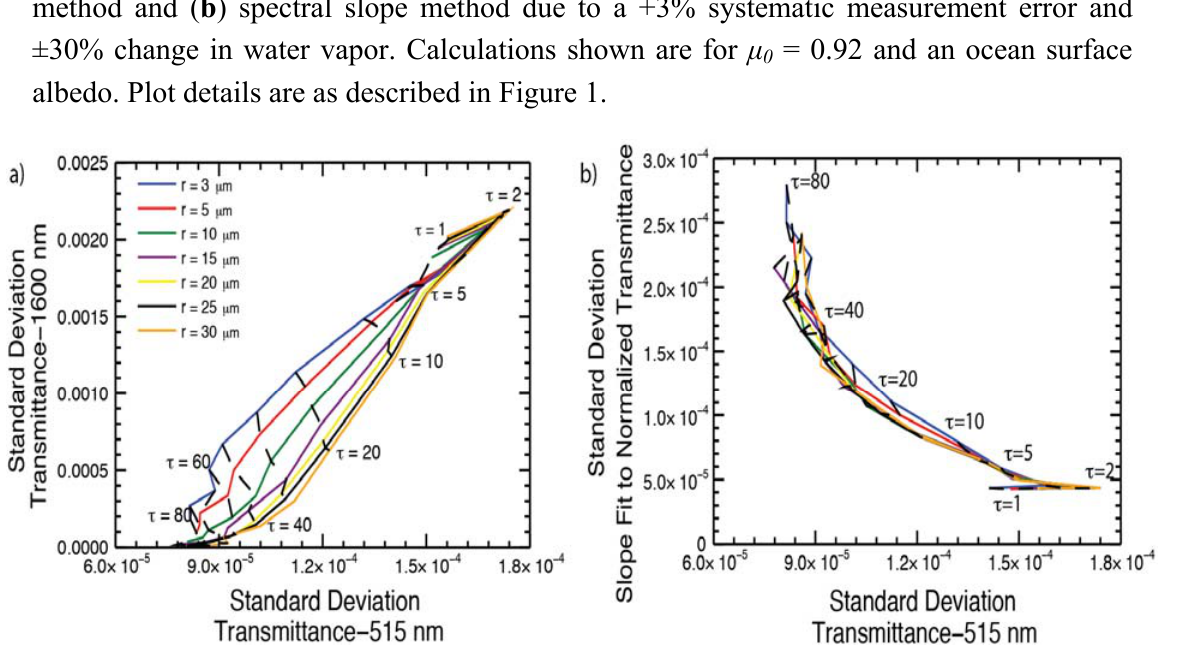
for ( a ) the standard e = 0.92 and an ocean surface 0